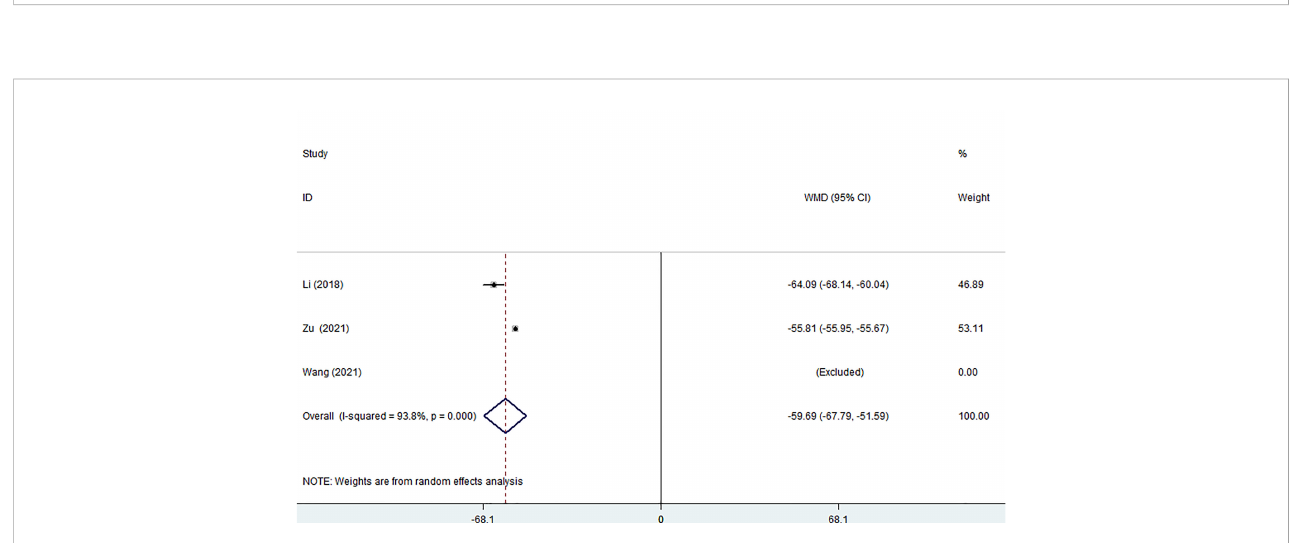
FIGURE 4 Forest plot of the size of surgical incision for comparing MWA with surgery in patient with PTMC. MWA, microwave ablation, PTMC, papillary thyroid microcarcinoma.